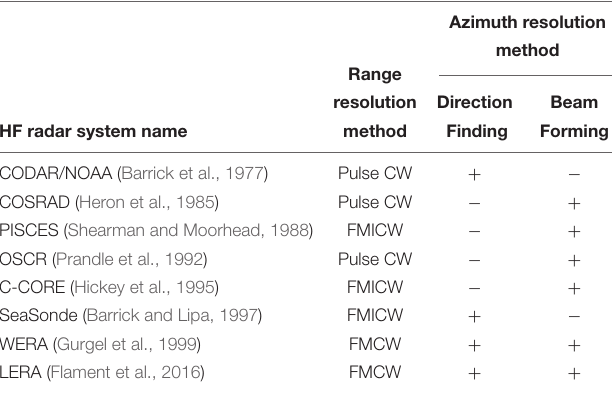
TABLE 1 | List of HF radar systems found in literature and their techniques for obtaining the range and azimuth of the sea echo.